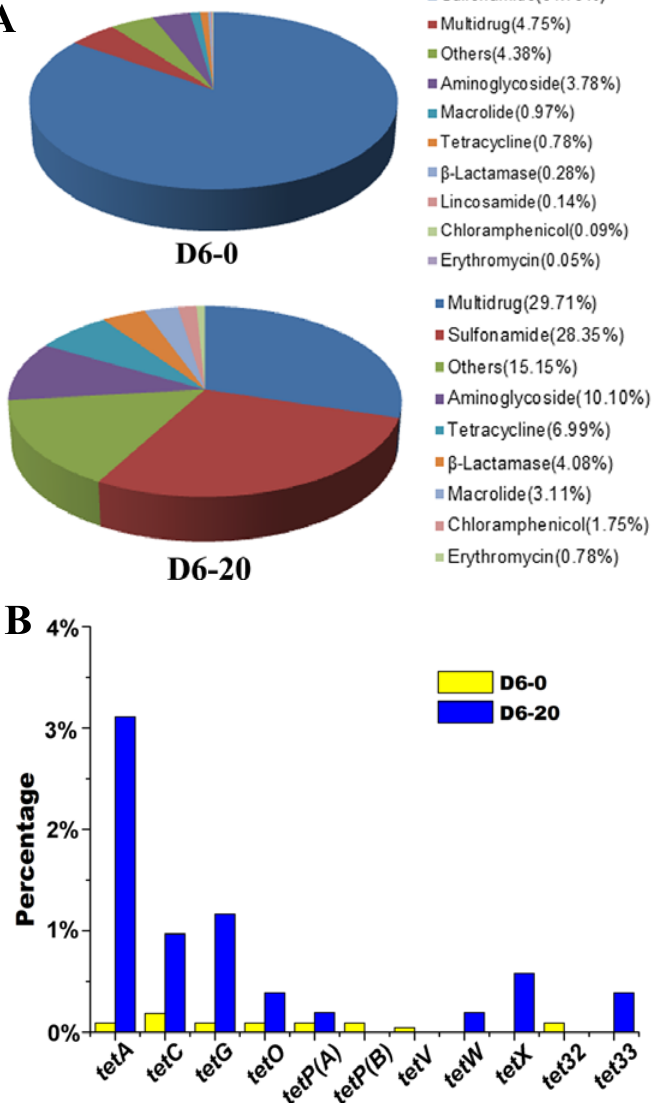
Figure 4. Antibiotic resistance patterns ( A ) and tet genes ( B ) in sludge treated with 0 mg/L (D6-0) and 20 mg/L (D6-20) tetracycline. The resistance genes identified were